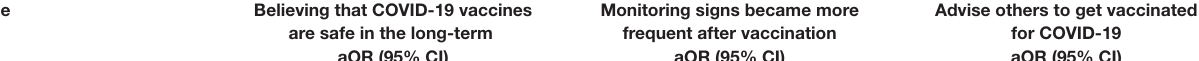
TABLE 7 | Logistic regression analyses for participants’ perceptions about COVID-19 vaccines after vaccination broken down by sociodemographic and health characteristics.